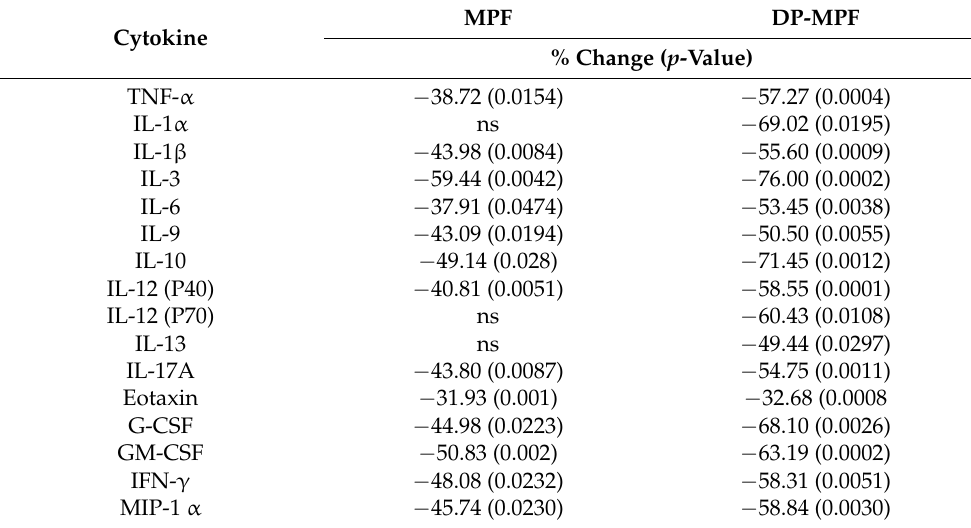
Table 2. Percentage inhibition of DC-derived pro-inflammatory cytokines and chemokines by MPF and